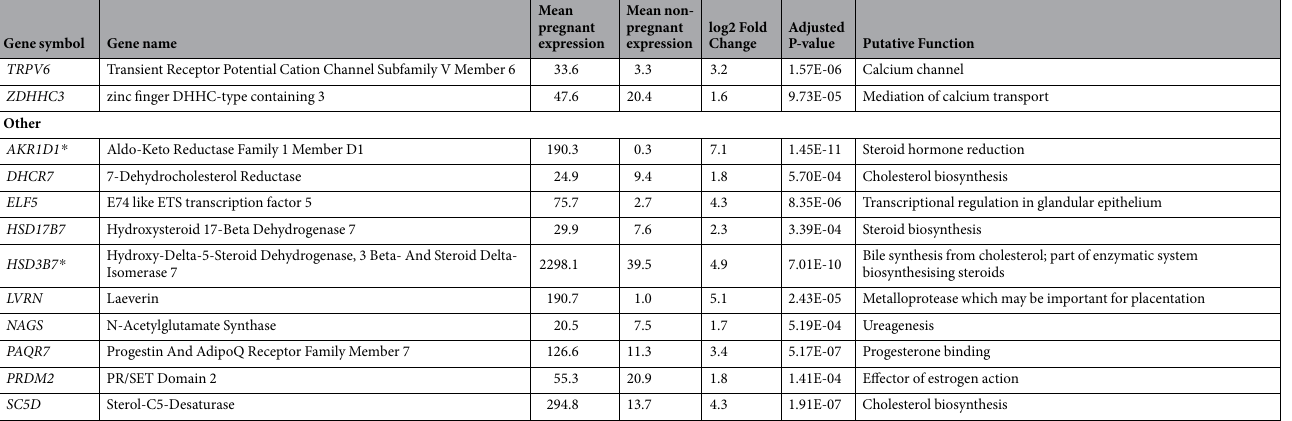
Table 5. Significantly up-regulated genes during pregnancy putatively involved in tissue remodelling, immune function, and transport. The table displays HUGO Gene Symbol of the best BLAST hit, log2 ratios, and FDR‐adjusted p‐values, along with mean expression values per stage. Mean expression values are normalized transcripts per million (TPM). Only genes with adjusted P-values < 0.001 are shown. * indicates top 100 differentially expressed